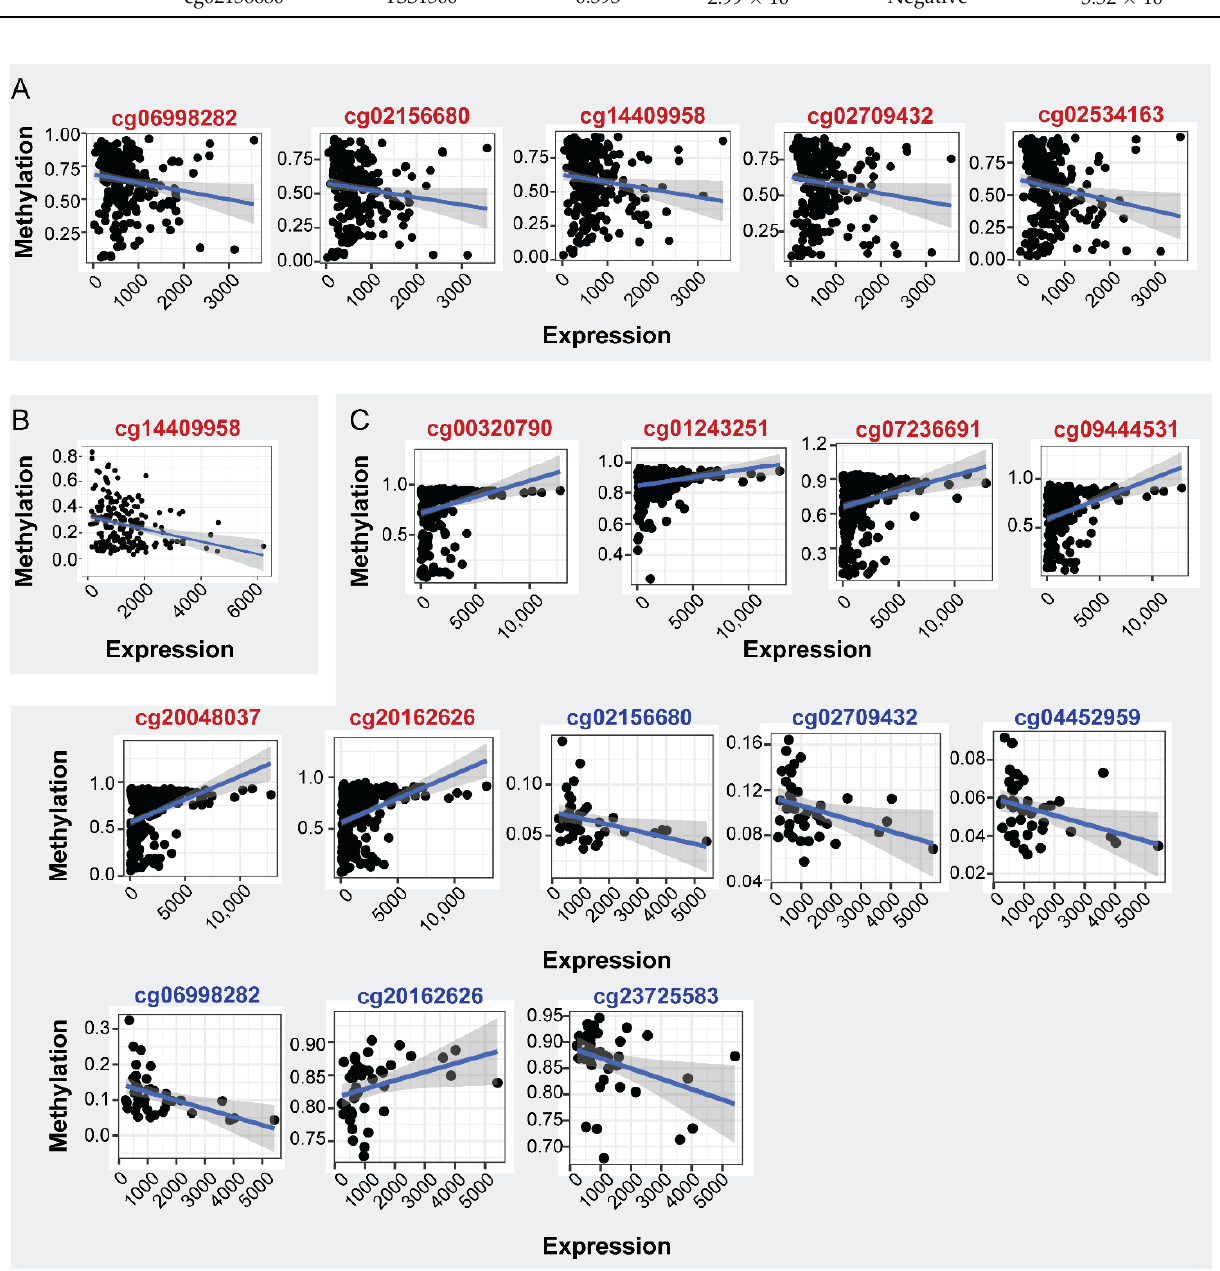
Figure 4. Correlation of ENPP2 CGs methylation and mRNA expression. CGs showing significant correlations are depicted ( p < 0.05). ( A ) Expression-methylation scatter plots of CG sites of PC and normal samples, ( B ) expression-methylation scatter plots of CG sites of LC and normal samples, ( C ) expression-methylation scatter plots of CG sites of HCC and normal samples. Correlations from cancer and healthy samples are marked in red and blue CG color font, respectively. Table 6. Spearman correlation coefficient between ENPP2 CG methylation and mRNA expression ( p < 0.05) for PC, LC and HCC samples, showing mainly a negative correlation with PA CG meth- ylation and in most cases a positive correlation with gene body methylation.